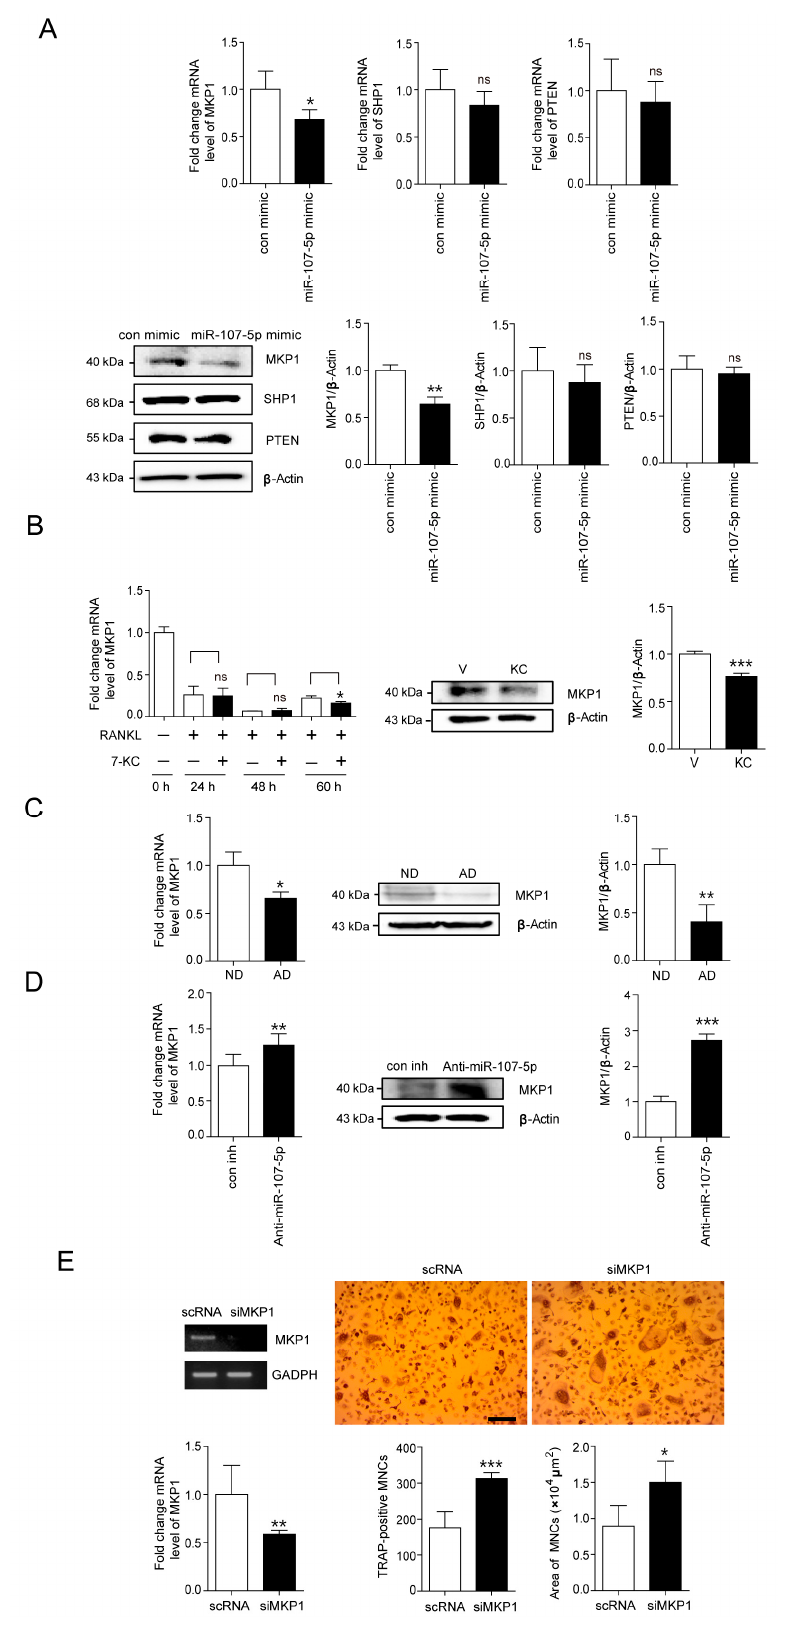
Figure 3. Identification of target for 7-KC-induced miR-107-5p in OCs. ( A,D ) BMMs were prepared, incubated with M-CSF (30 ng/mL) and RANKL (40 ng/mL) for 48 h, and transfected with 30 nM of miR-107-5p mimic or con mimic ( A ). BMMs were incubated with M-CSF, RANKL, and 7-KC (7 μ M) for 48 h and transfected with 30 nM of anti-miR-107-5p or con inh. ( D ). Cells were incubated for 17 h and total RNA was analyzed by qPCR to quantify the expression of MAP kinase phosphatase 1 (MKP1), Src homology region 2 domain containing phosphatase-1 (SHP1), and phosphatase and